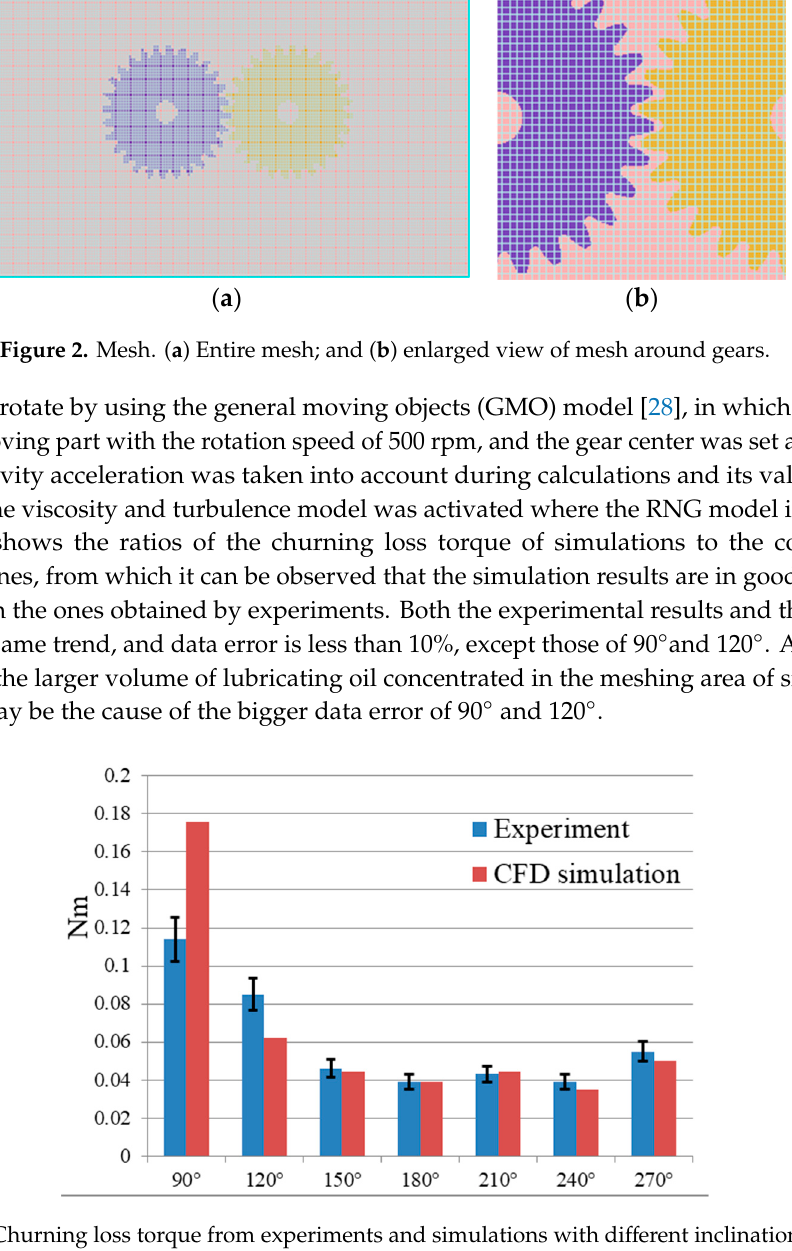
Figure 3. Churning loss torque from experiments and simulations with different inclination angles.